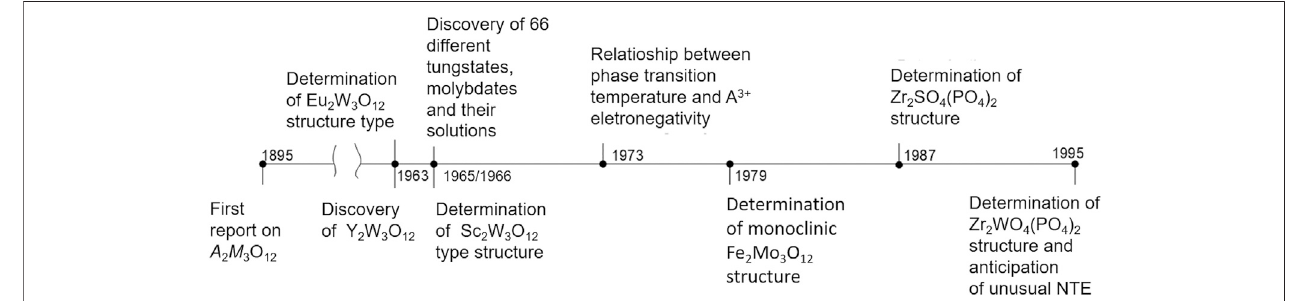
FIGURE 2 | Timeline of the main discoveries and milestone papers in the pre-NTE era of the A 2 M 3 O 12 family of ceramics.